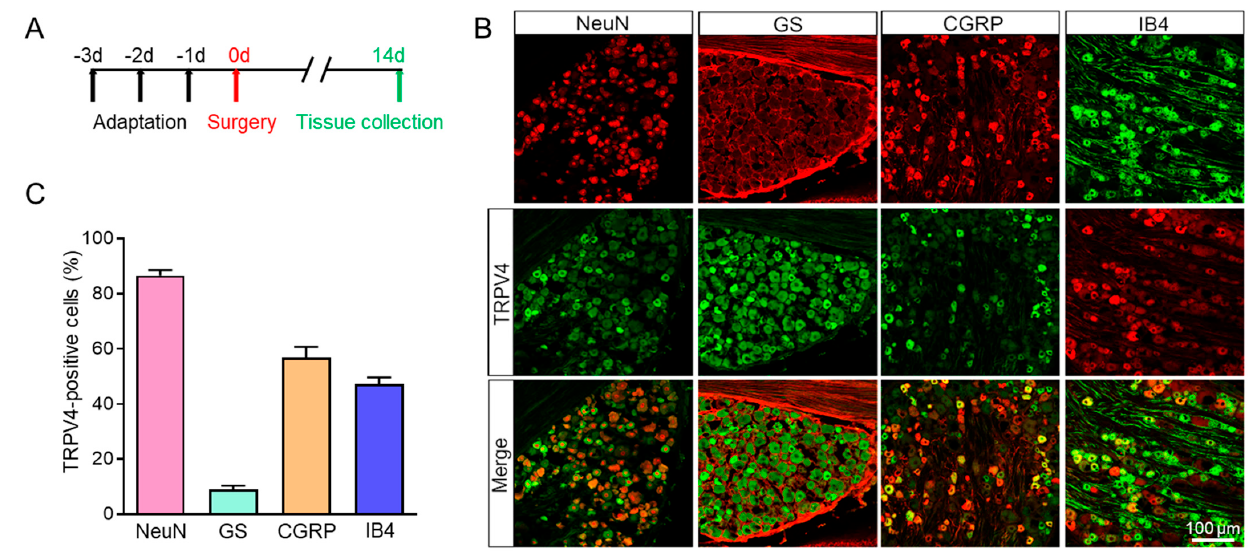
Figure 3. Immunofluorescence assay of TET1 in the L4–6 DRG of BCP rats. ( A ) The schematic dia- gram. ( B ) TET1-positive DRG cells (middle row) were mainly co-labeled as neurons (NeuN) but not with satellite glial cells (GS). TET1 was co-expressed in CGRP-positive and IB4-positive DRG neu- rons. ( C ) The proportion of TET1-positive cells in different cell types, n = 4.